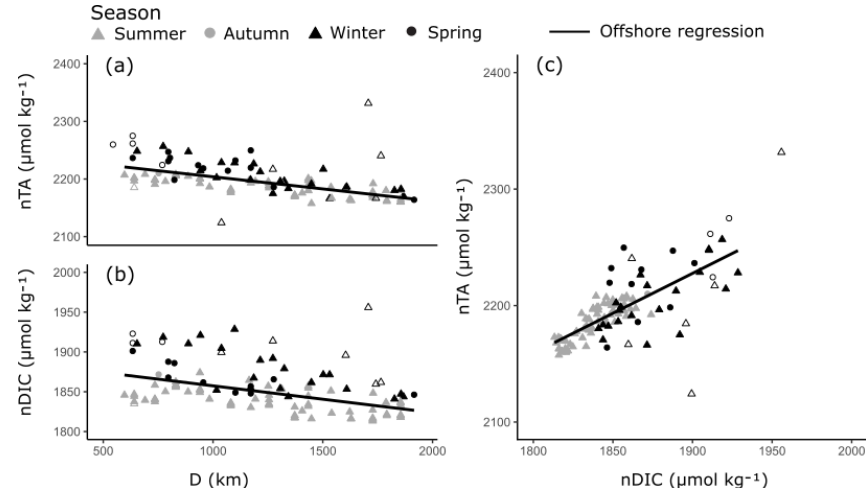
Figure 5. Linear relationships in nTA and nDIC along the south–north central axis of the Red Sea (a–b) and between nTA and nDIC (c) in the offshore waters. Symbols indicate the season in which samples were collected. All linear relationships were statistically significant and offshore outliers were not included in the linear regressions (hollow